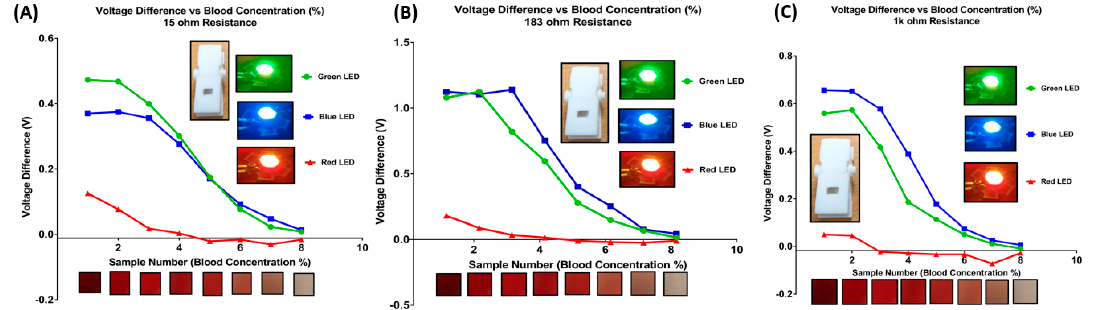
Figure 8. Performance comparisons for di ff erent resistance values of 15 ohms ( A ), 183 ohms ( B ), and 1 k ohms ( C ). Despite the change in resistance, results have shown that the performance between the three color spectrums remains the same, with red color light spectrum the worst among the three and the blue and green light spectrum to be equally comparable under the normal light intensity condition.